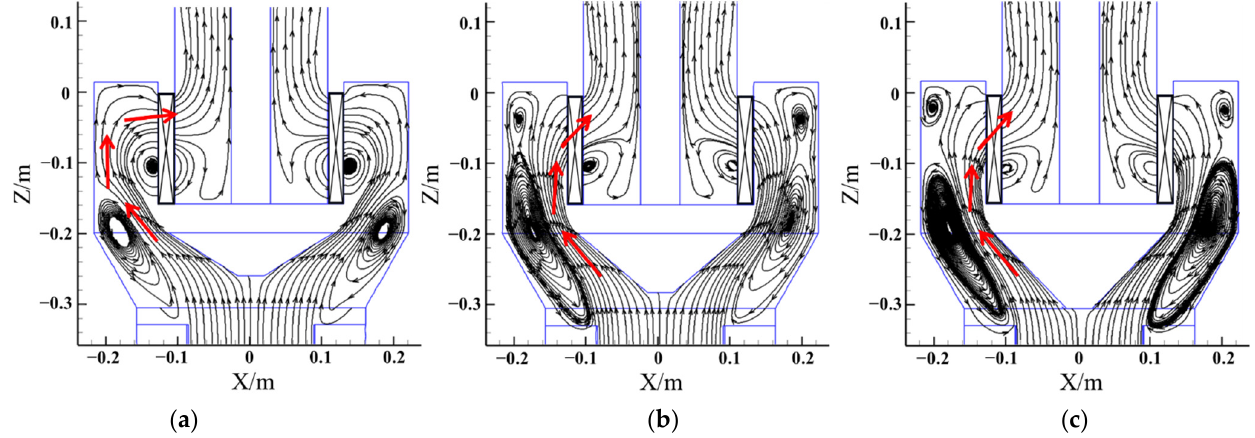
Figure 4. Effect of the guide cone height on airflow movement: ( a ) H = 64 mm, ( b ) H = 84 mm, ( c ) H = 104 mm. ( c ) H = 104